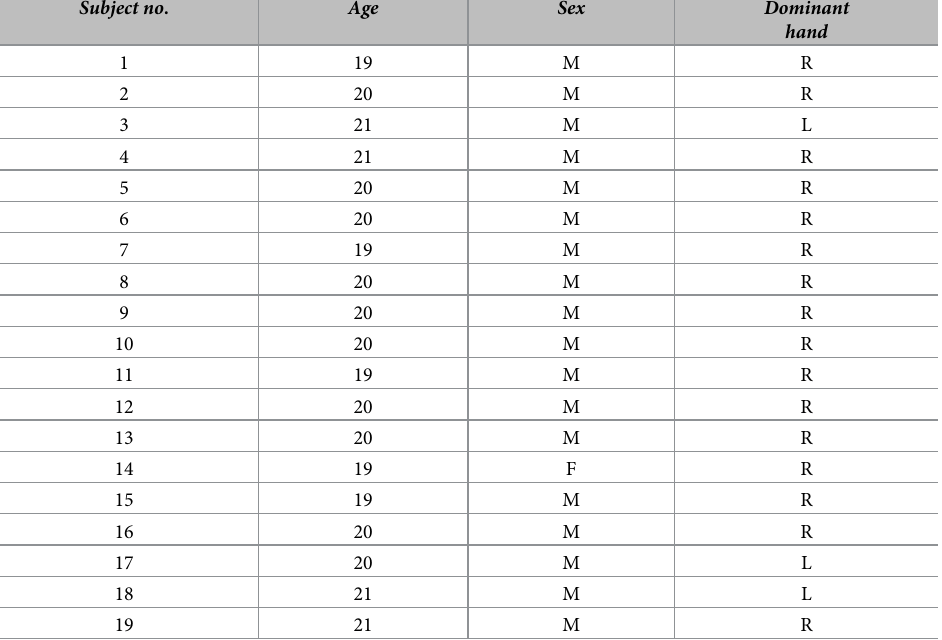
Table 1. Subject information: Age, sex, and dominant